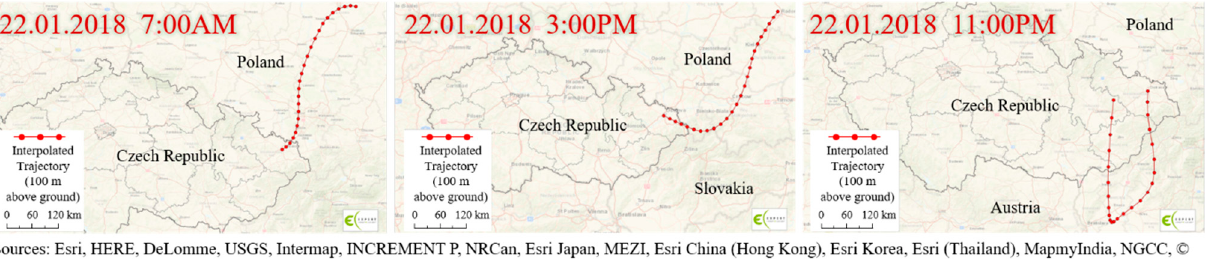
Figure 6. A 24 h air pollutant dispersion trajectory for Ostrava, calculated for 22 January 2018 .